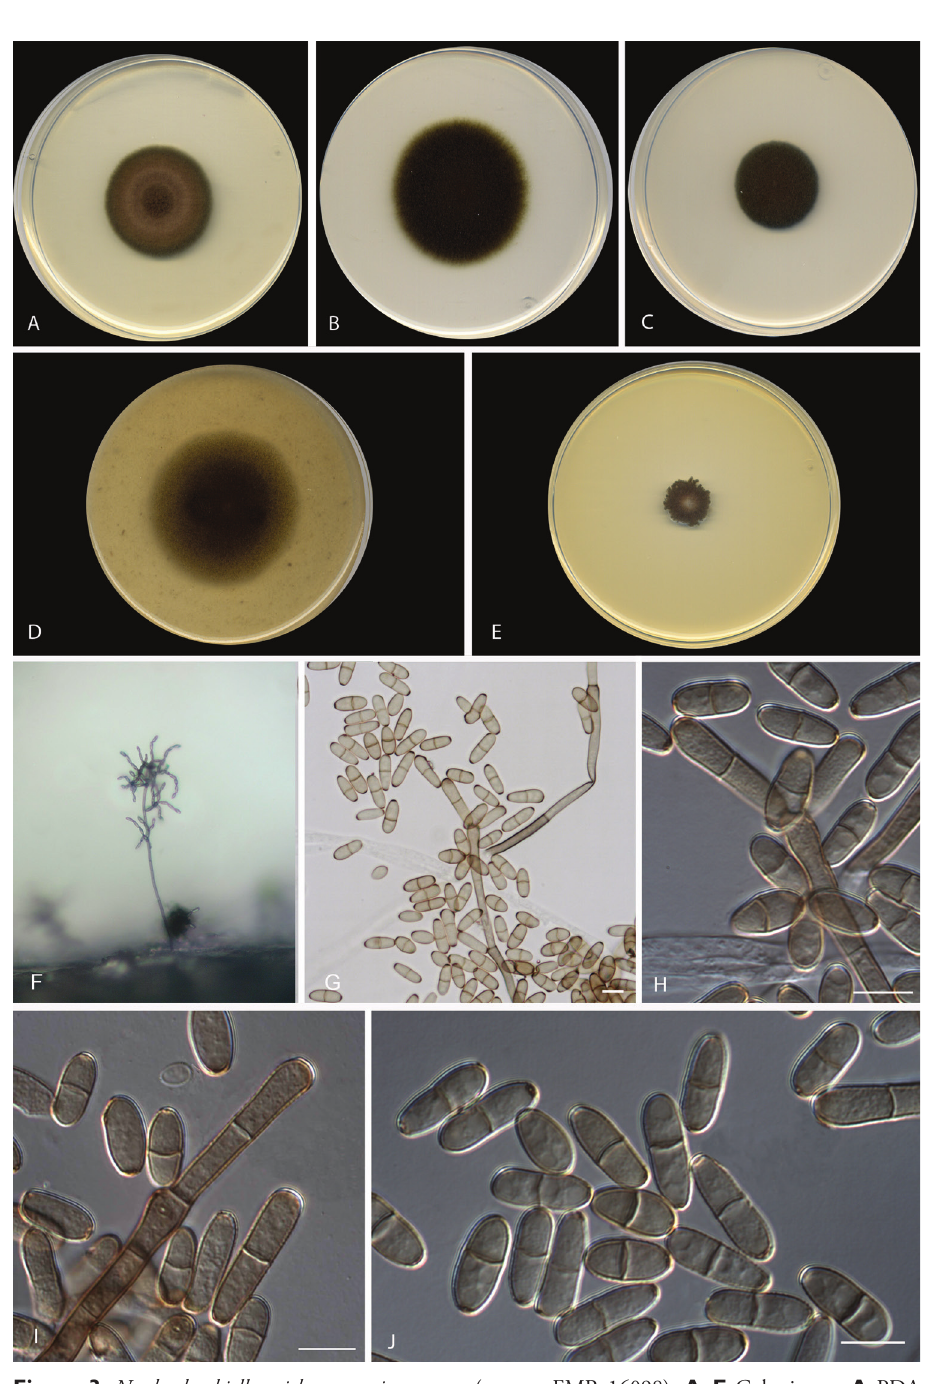
Figure 3. Neodendryphiella michoacanensis sp. nov. (ex-type FMR 16098). A–E Colonies on A